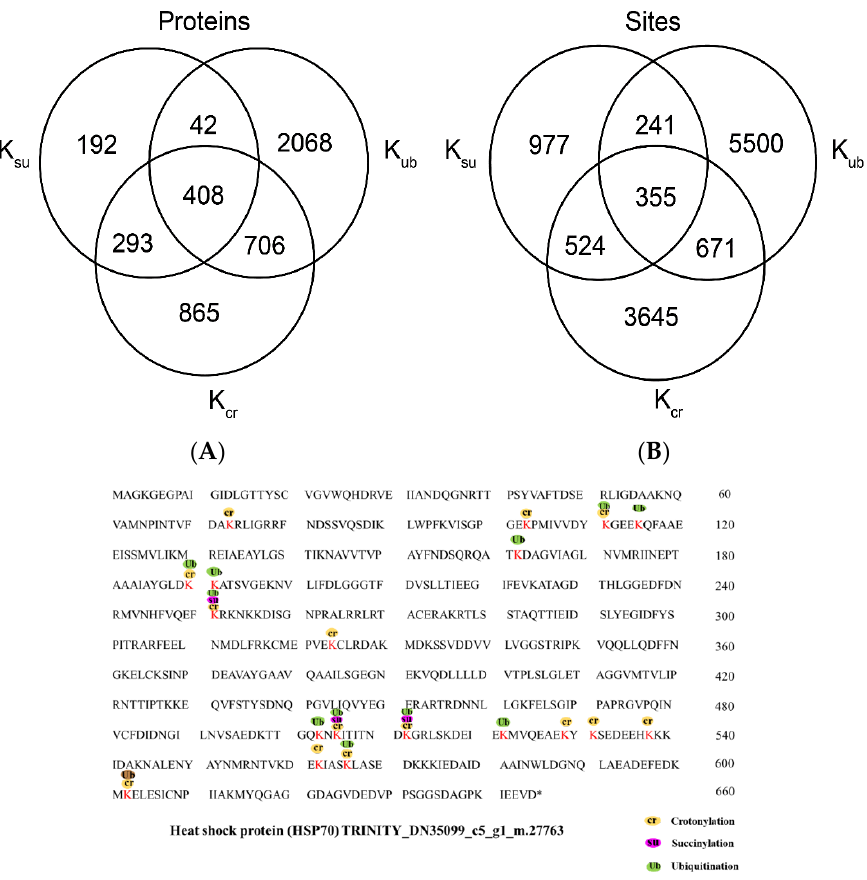
Figure 7. Analysis of proteins modified by crotonylation, succinylation, and ubiquitylation. ( A ) Overlap of crotonylated (Kcr) proteins in this study with reported paper mulberry succinylated (Ksu) and ubiquitylated (Kub) proteins. ( B ) Overlap of crotonylated lysine residues in this study with reported succinylated (Ksu) and ubiquitylated (Kub) lysine residues in paper mulberry. ( C ) Analysis of heat shock protein (HSP70) modified by crotonylation, succinylation and ubiquitination.